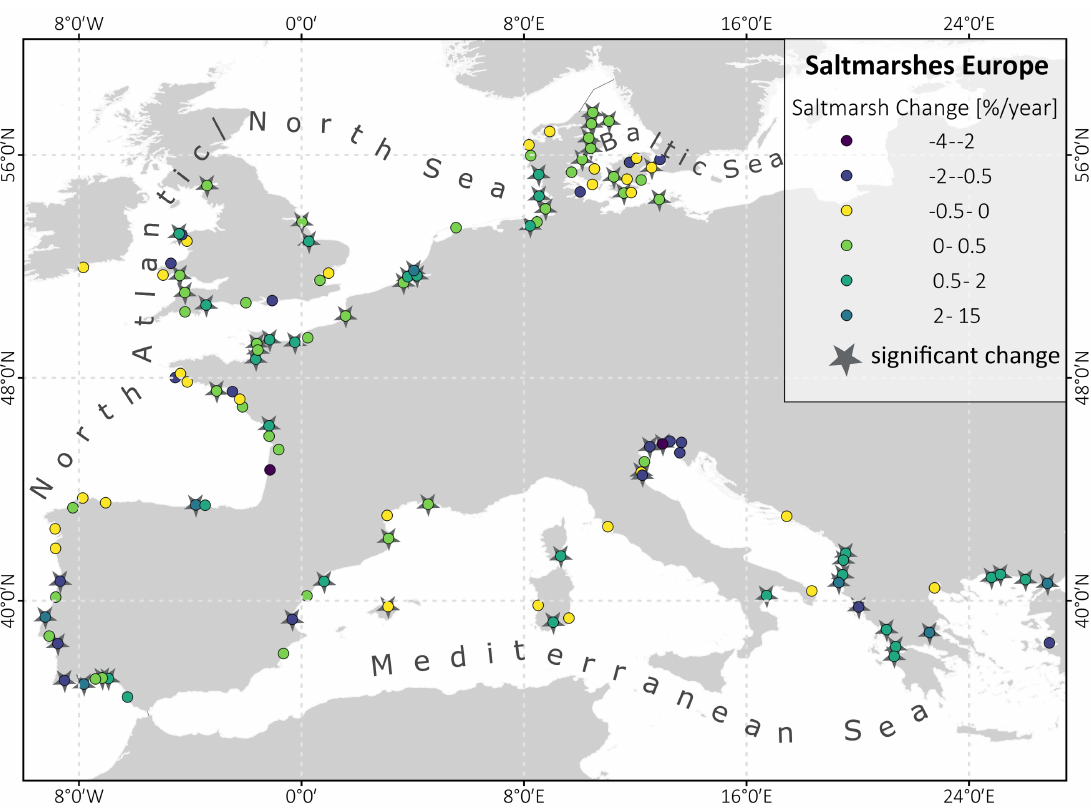
Figure 8. Map of European saltmarshes showing annual relative (%/year) change in the seaward extent of saltmarshes and whether or not the detected trends between 1986 and 2010 are